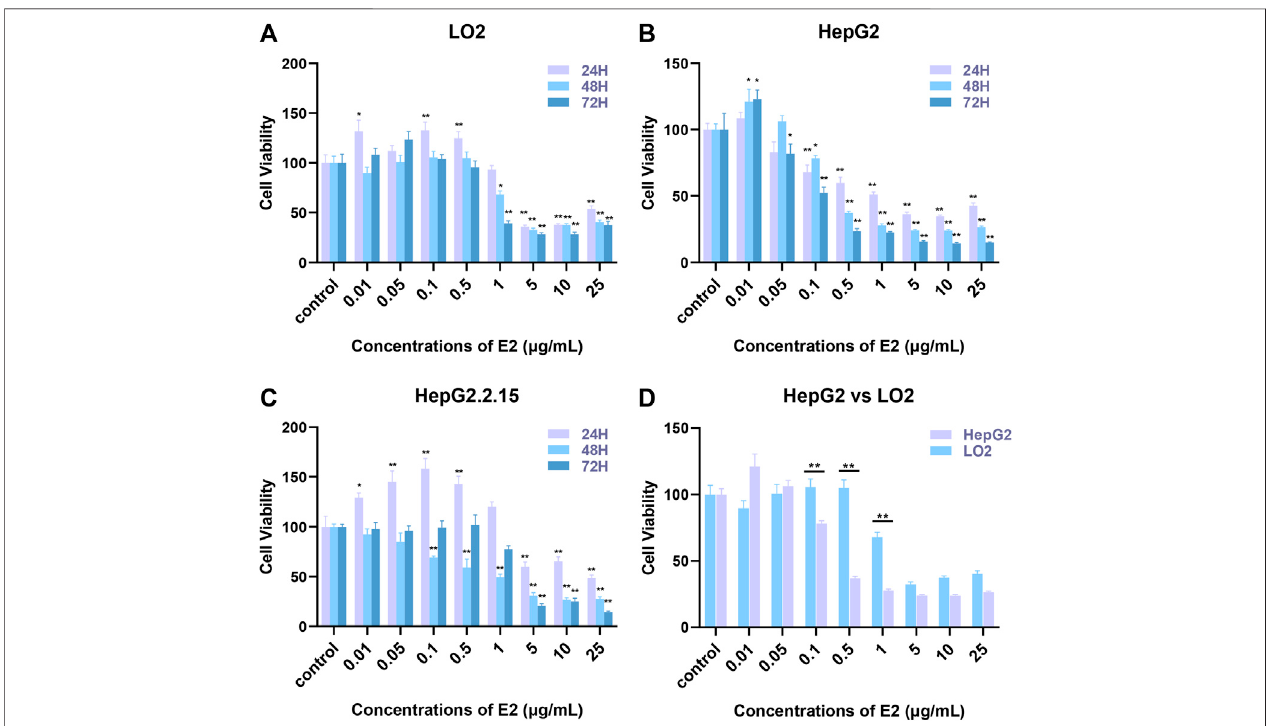
FIGURE 1 | The effects of 17 β -estradiol on the proliferation of HepG2, HepG2.2.15, and LO2 cells. (A – C) The histograms show the effects of various levels of the hormone at different times, compared to control groups. * p < 0.05, ** p < 0.01. (D) The histogram compares HepG2 and LO2 cell proliferation during 17 β -estradiol treatment over 48 h, ** p <